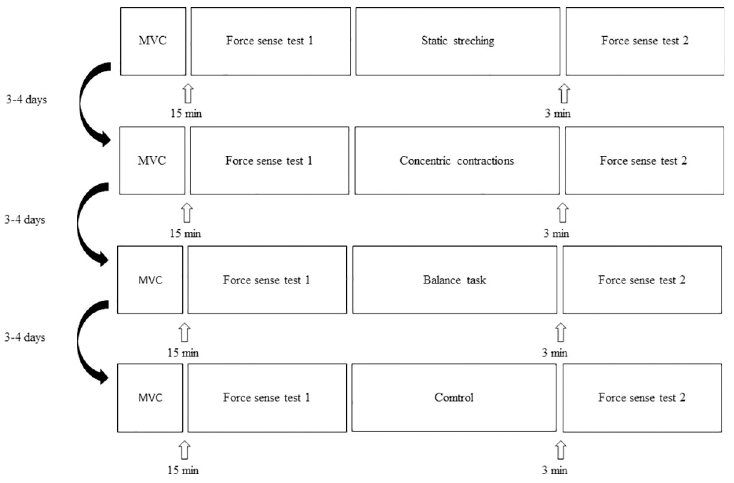
Fig 1. Overview of four experimental sessions. Four exercise modalities were applied in random